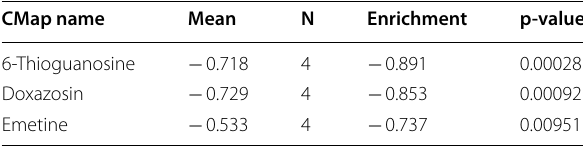
Table 3 Results of CMap